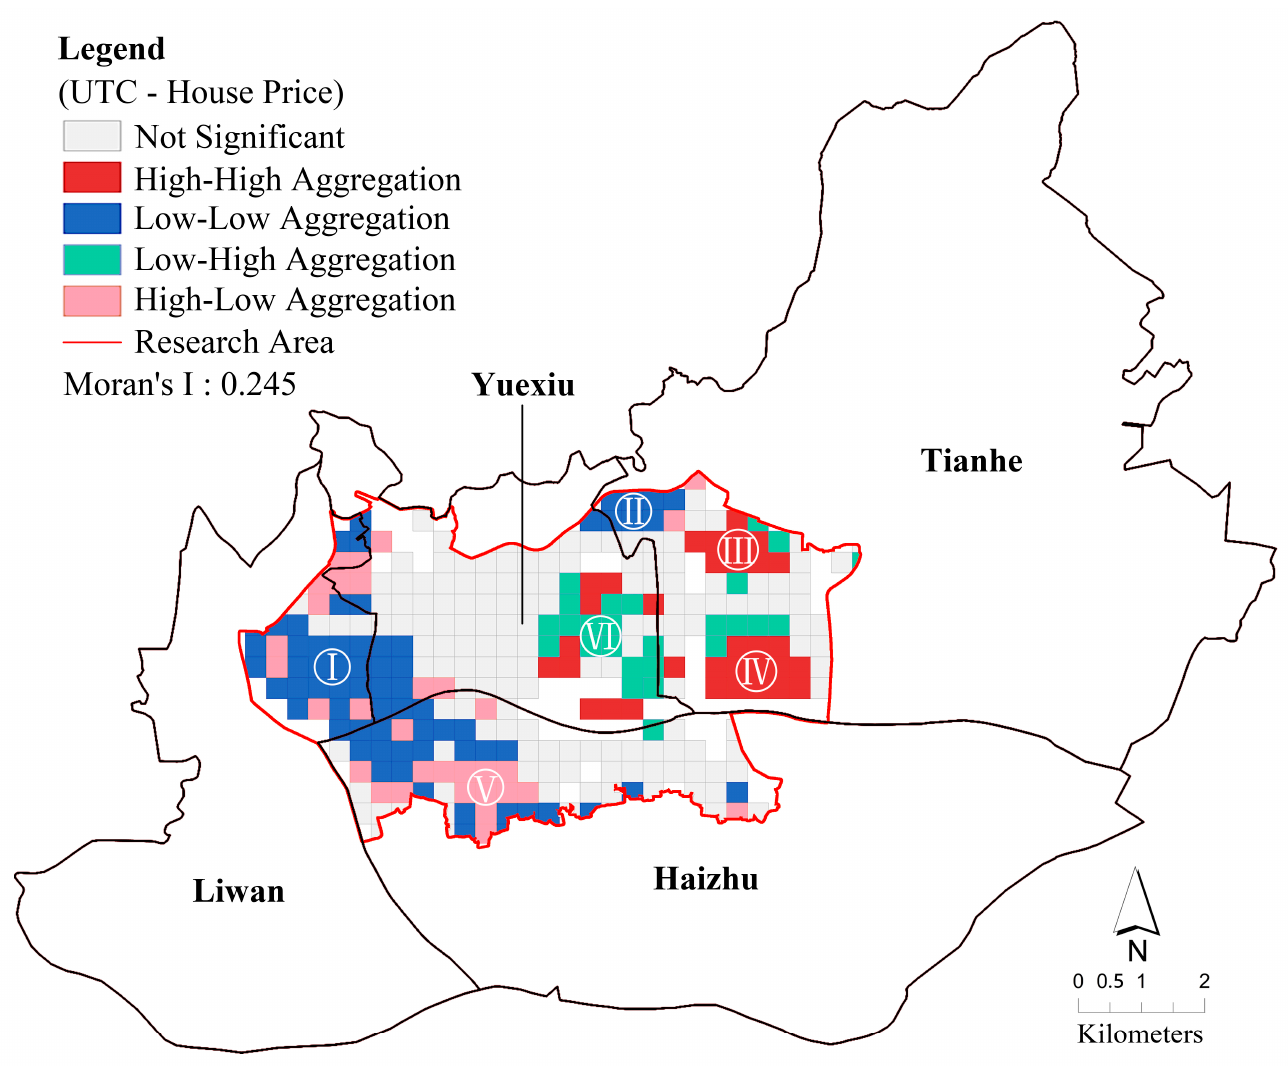
Figure 4. Bivariate local spatial autocorrelation analysis of UTC and house price.